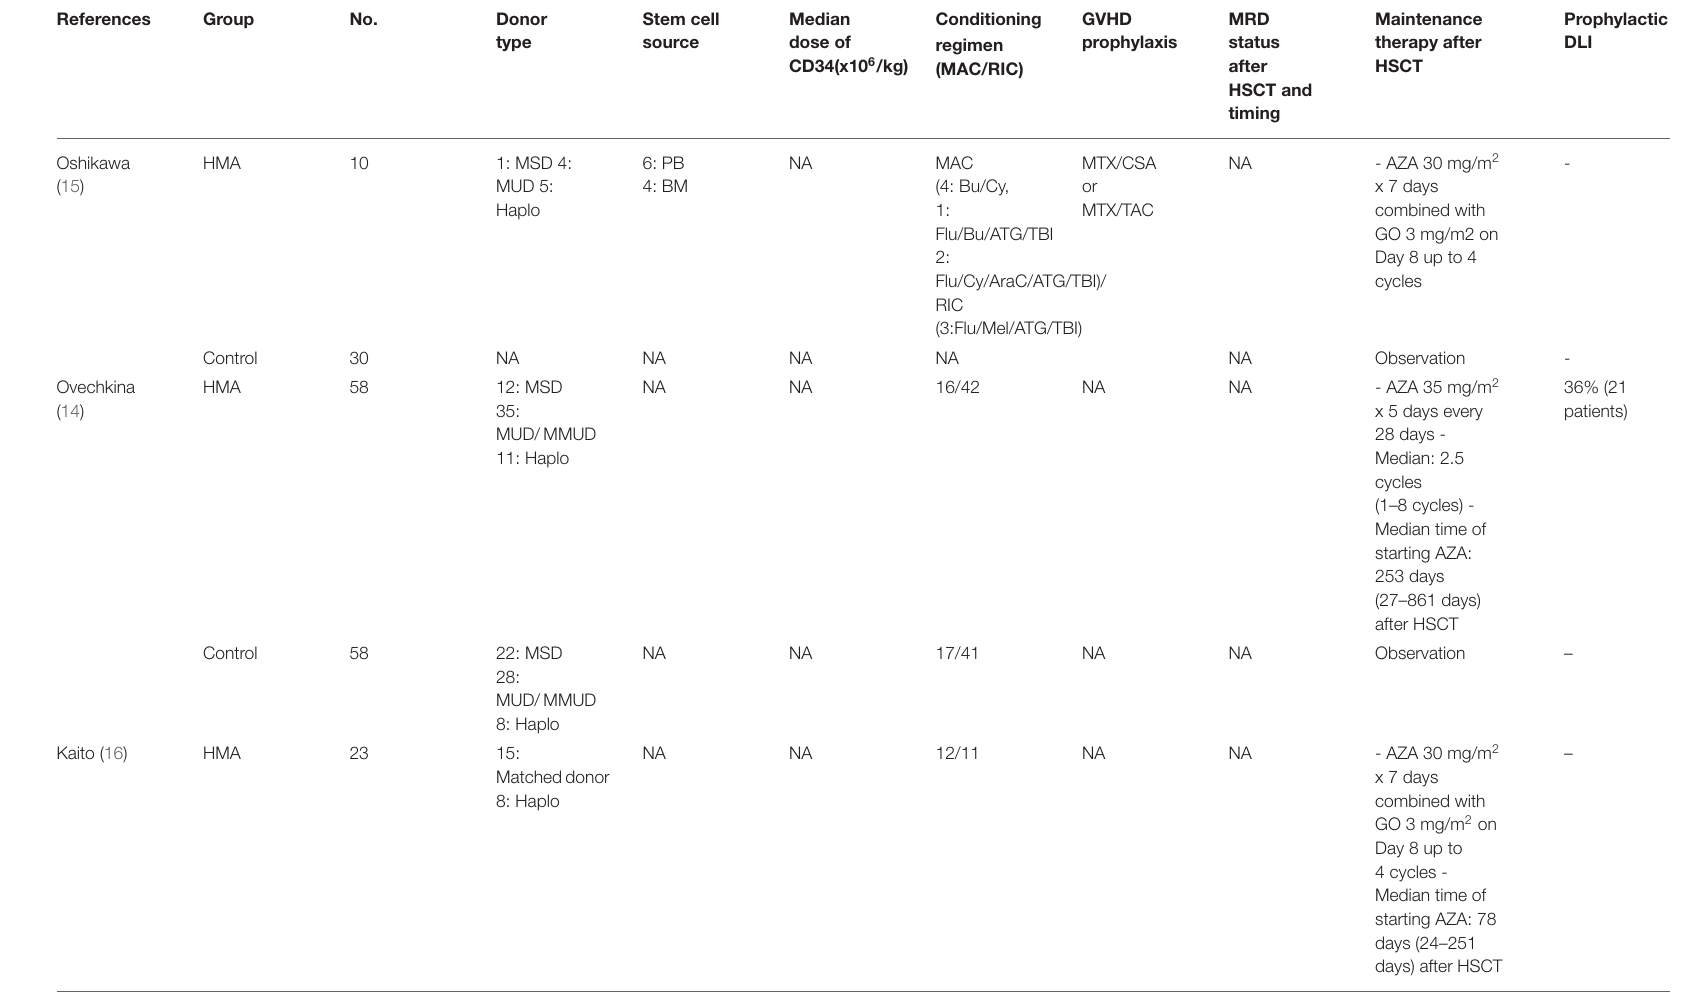
TABLE 2 | Peri- and post-transplantation information of studies included in the